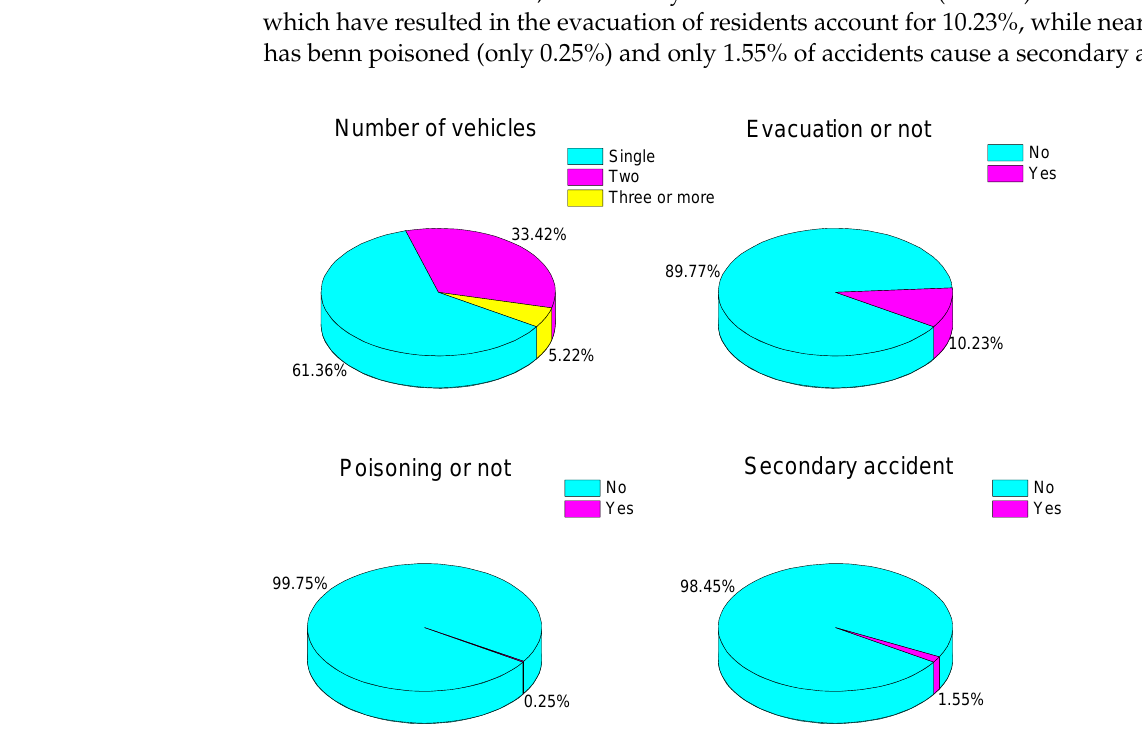
Figure 10. Distribution of Accidents by the number of vehicles, evacuations, poisonings, and sec- ondary accidents.